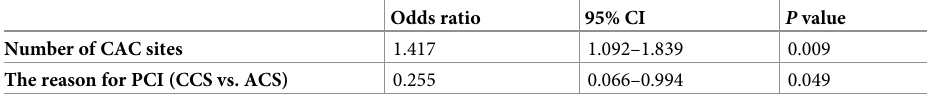
Table 3. Risk factors of future cerebrovascular events on multivariate